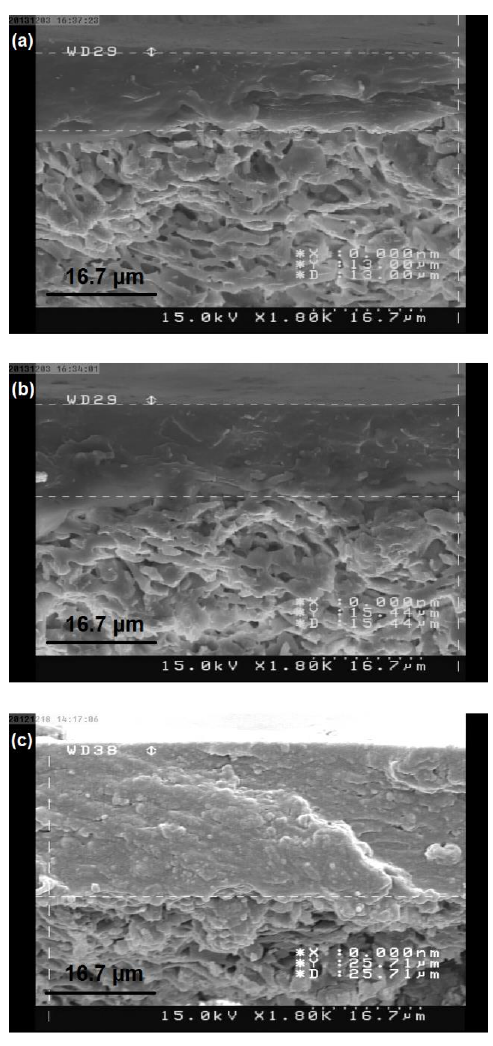
Figure 4. The FE-SEM images of the chitosan membrane cross section at different concentrations. ( a ) 2 wt.%; ( b ) 3 wt.%; ( c ) 4 wt.%.